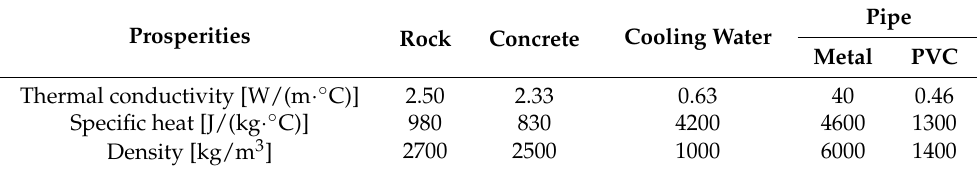
Table 1. Thermal properties of rock, concrete and cooling pipe.